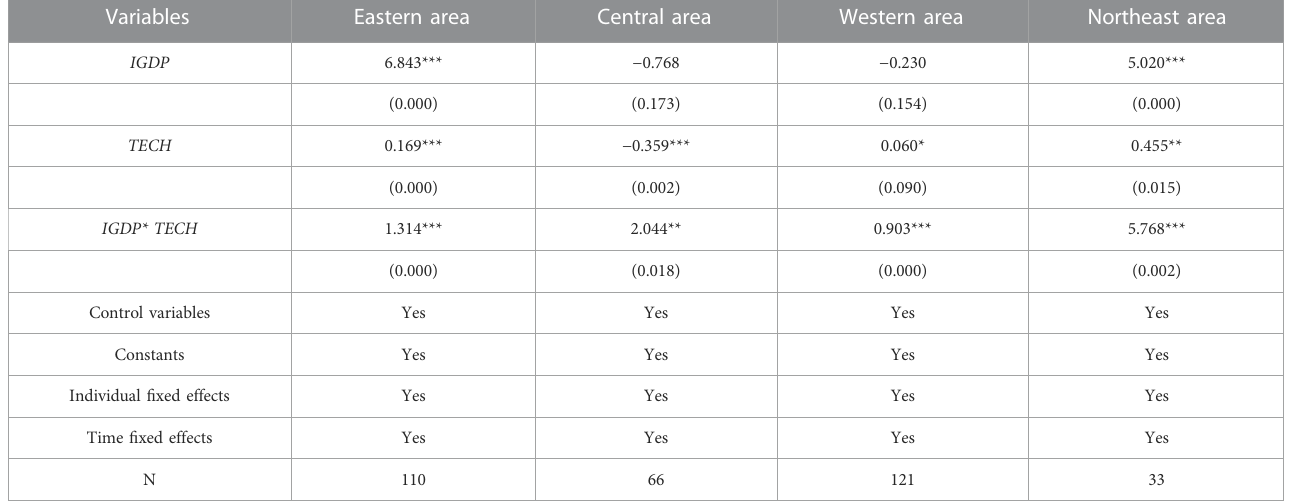
TABLE 9 Regression results of regional heterogeneity.